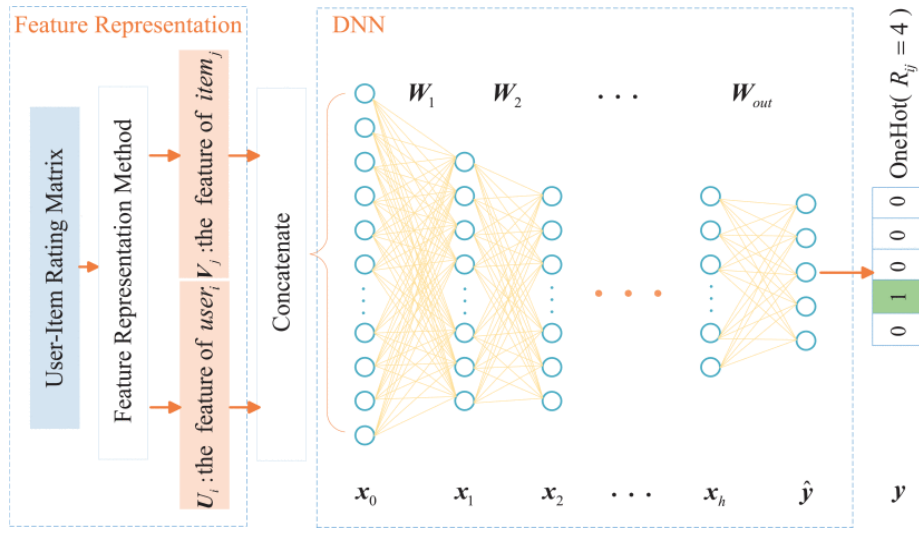
Figure 4. DNN architecture Model.